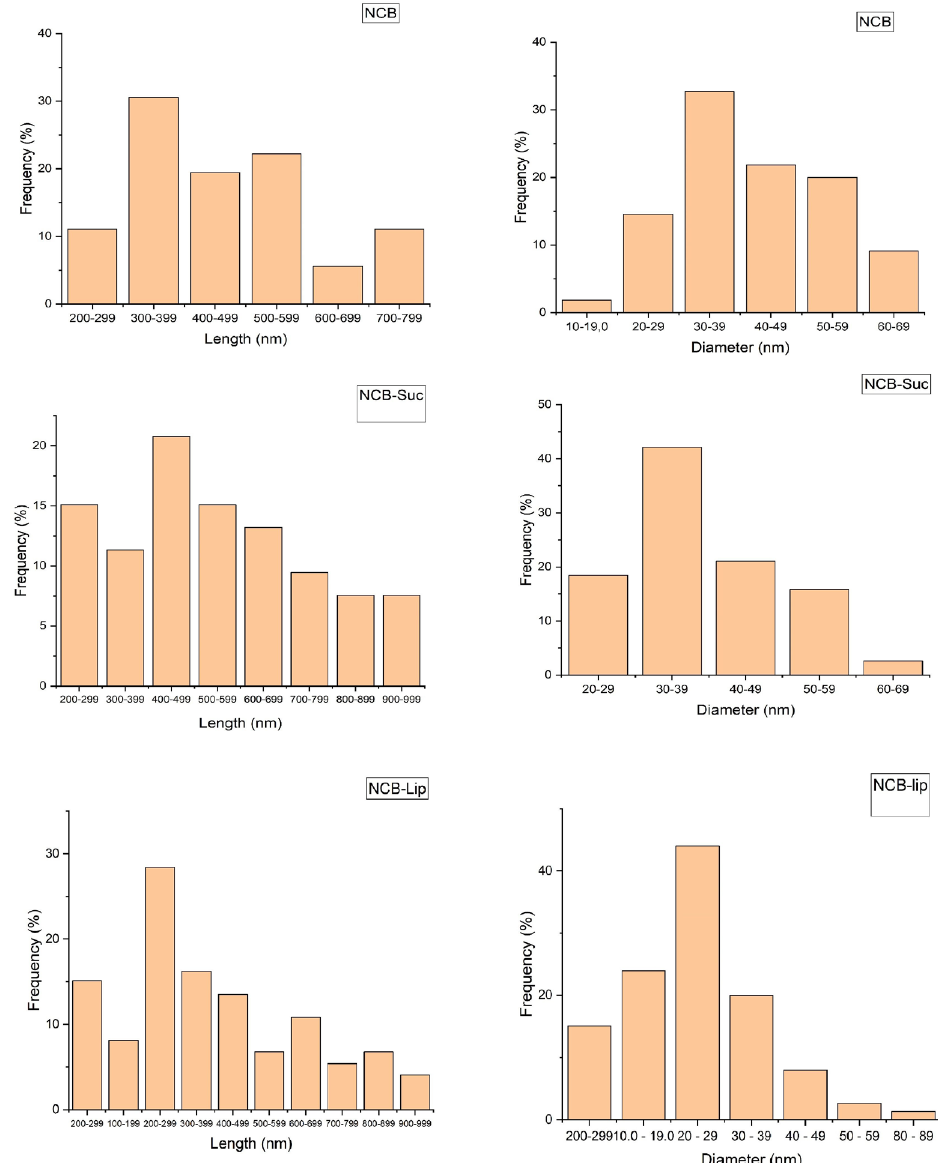
Figure 5. Distribution of the diameter and length of the pristine, succinylated, and lipase-conjugated NCBs.